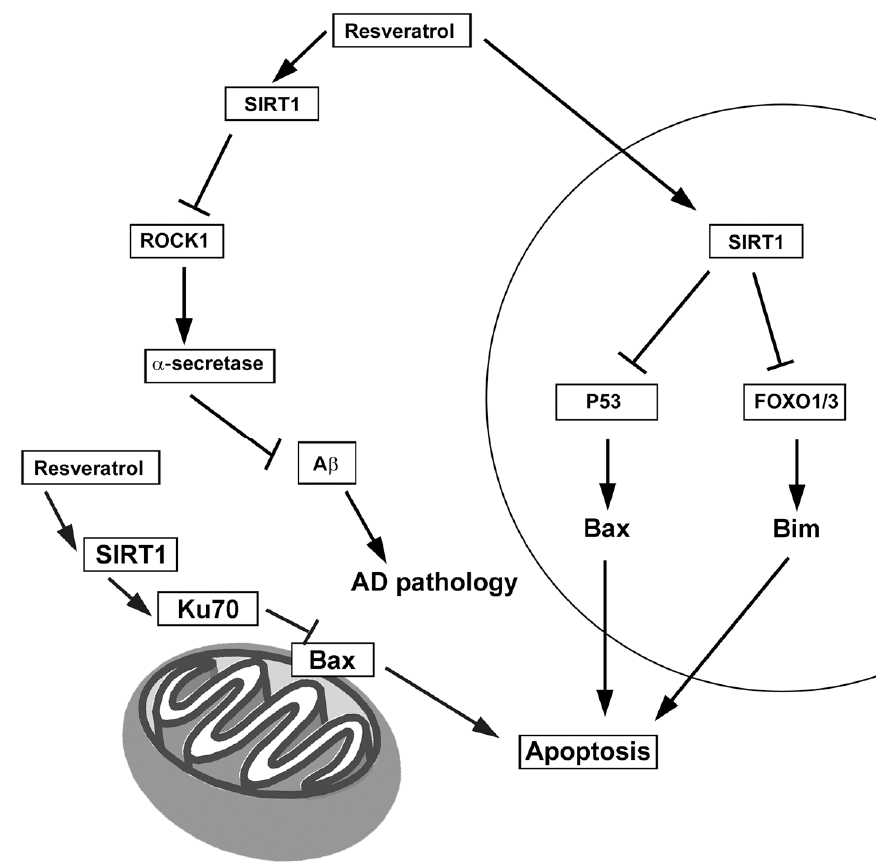
Figure 6. Pro-survival effects of SIRT1. The schematic demonstrates the downstream consequences of nutraceutical activation of